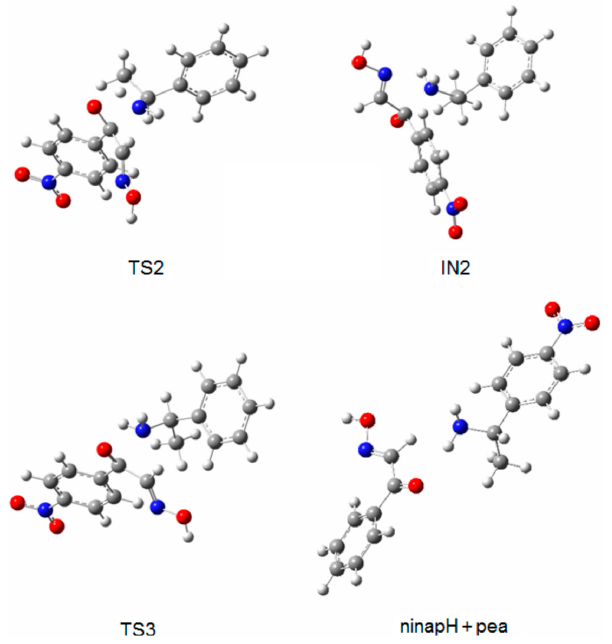
Figure 3. Optimized structures of TS2, IN2, TS3 and ninapH + pea.